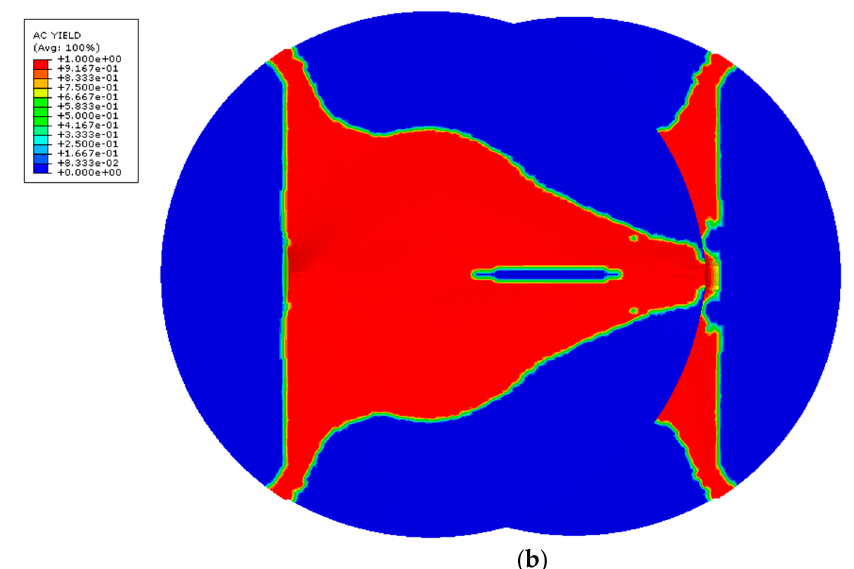
Figure 13. Triangular stress distribution and corresponding yield regions: ( a ) Mapping of von Mises stress; ( b ) Mapping of yielded regions.